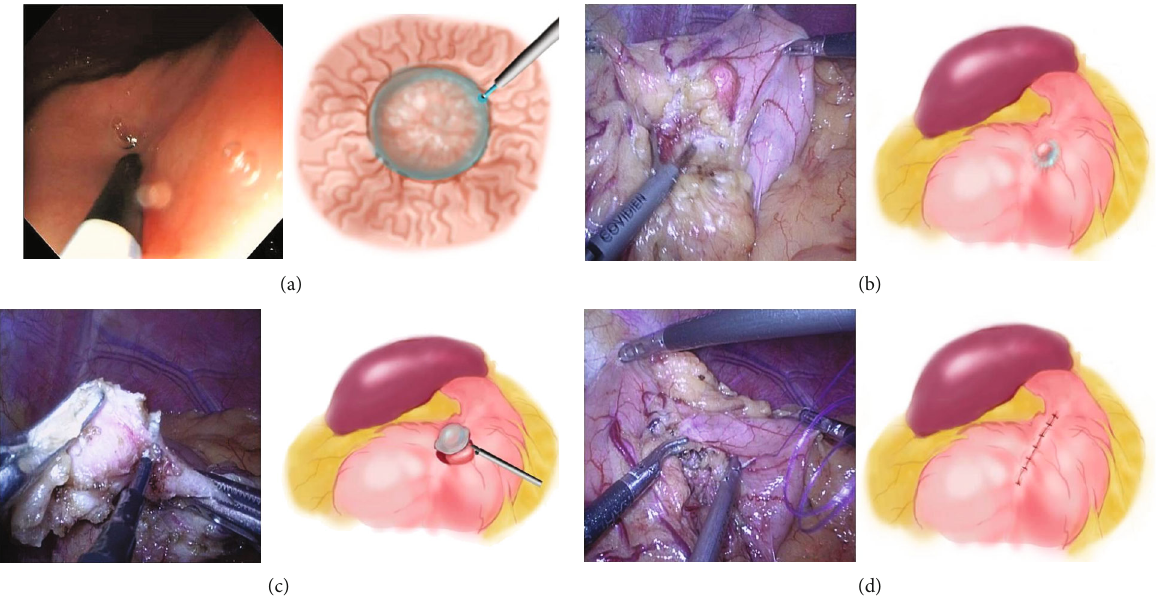
Figure 1: Real-time images and schematic procedure of laparoscopic and endoscopic cooperative dissection (LECD) for small GISTs. (a) Indigo carmine dye was endoscopically injected into the submucosal layer. (b) The position of the tumor was observed under laparoscopy. (c) The gastric serous layer was cut open; the tumor was dissected using image-guided laparoscope. (d) To suture the incision of gastric serosa under the